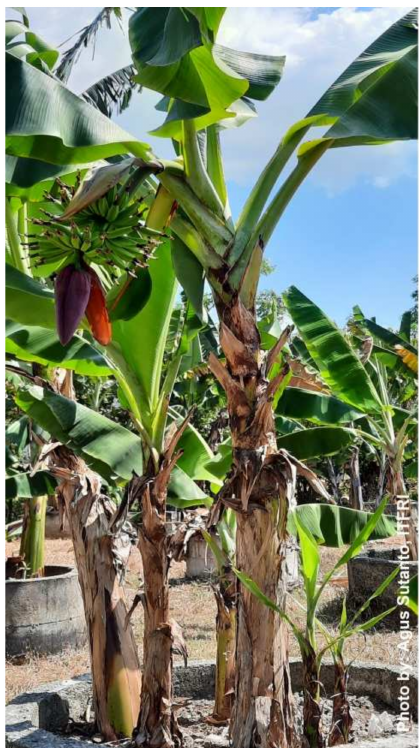
Figure 2. The structure of a banana